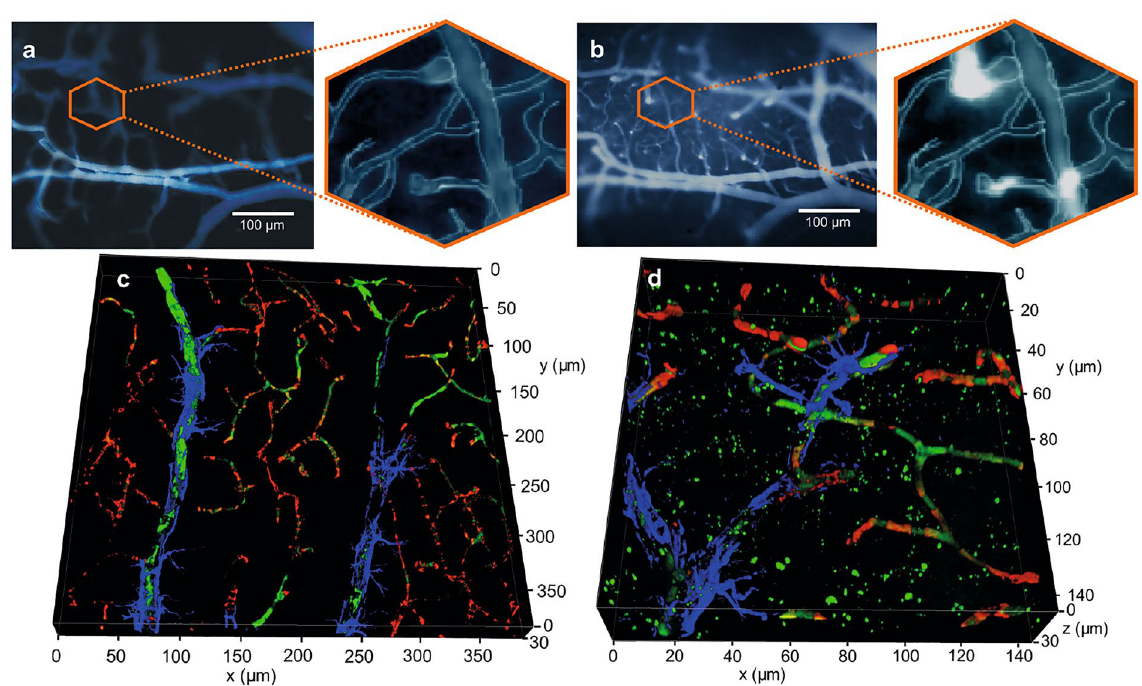
Figure 2. The sound-induced OBBB to the albumin complex of ED (68 kDa): ( a,b )—in vivo real time fluorescent microscopy of the cerebral microvessels filled ED (no EB leakage) before music exposure ( a ) and EB extravasation from the cerebral capillaries into the brain tissues after music impact indicating OBBB ( b ); ( c , d )—confocal imaging of brain slices in rats with the intact BBB ( c ) and with OBBB ( d ); the brain microvessels (red color) were labeled NG2, astrocytes (blue color) were labeled by GFAP; the extravasation of the albumin complex of ED ( b , d ) is shown as a bright fluorescence ( b ) around the cortex capillaries and green points ( d ) among the cerebral microvessels and astrocytes. In Fig., ( a , b ) panels were produced by microscope (Axio Imager A1, Zeiss, Germany) equipped with CMOS camera (acA1920-40uc, Basler AG, Germany), 10 × 0.3 objective lens and Evans Blue dye filter sets 49019 (Chroma, USA); ( c , d ) panels were imaged by confocal microscope (Leica SP5, Germany). The final collages were generated using the licensed program Colel Draw X8 (https:// www. corel draw.